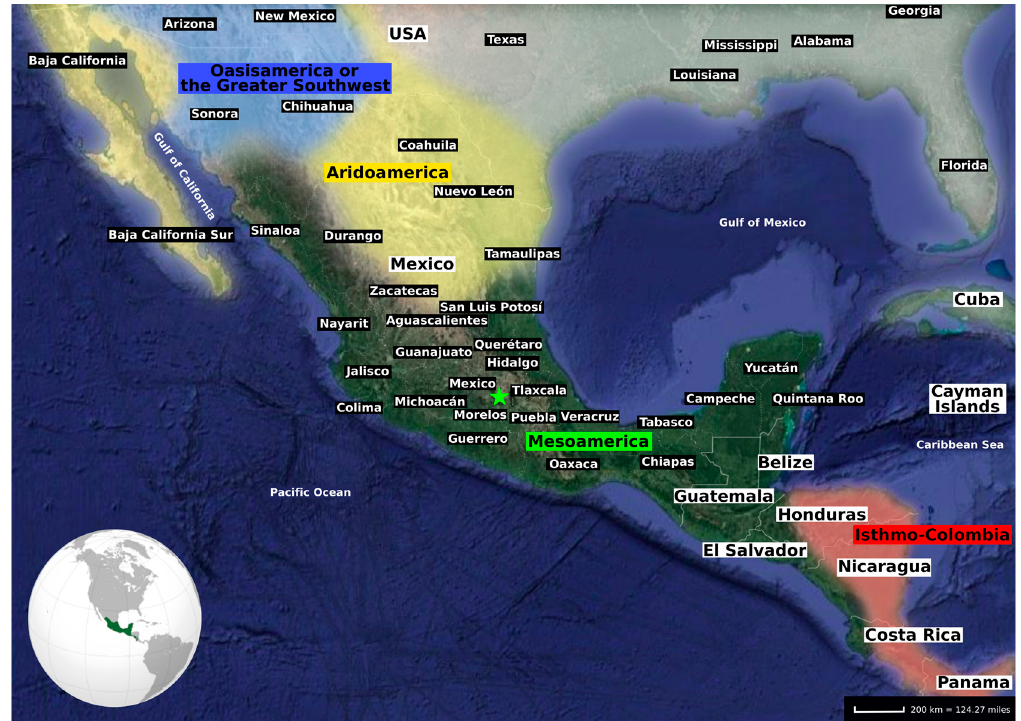
Figure 1. The historical and cultural area of Mesoamerica, as well as Isthmo-Colombia, Aridoamerica, and Oasisamerica (also known as the Greater Southwest) represented with coloured shades. Regions outside these areas are depicted with a white shade. Of note, Oasisamerica is occasionally included in Aridoamerica in the literature. White lines delineate the modern-day borders between countries and white dashed lines the borders between states. The green star is the localisation of present-day Mexico City.